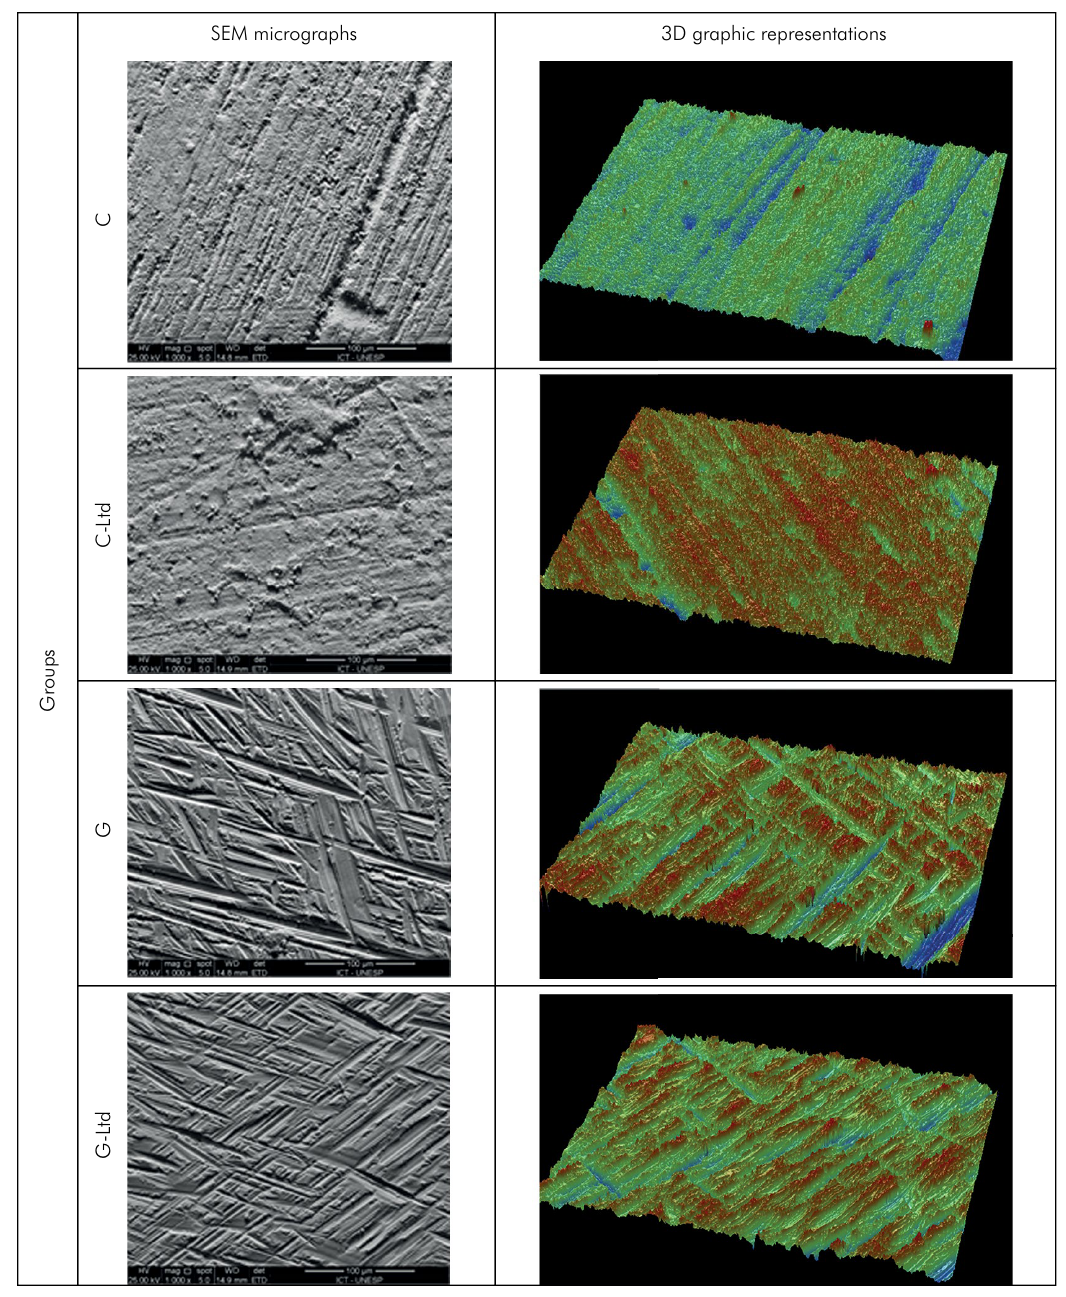
Figure 1. SEM micrographs (1000 x magnification) and 3D graphic representations showing different topographical patterns of specimens subjected to studied conditions. It highlights that both evaluated ceramic thicknesses (0.5 and 1 mm) presented the same topographical pattern and that grinding procedure affects the materials topography changing its superficial pattern, while low temperature aging appears to not interfere in such outcome (C- as-sintered; G- grinding; Ltd- low-temperature